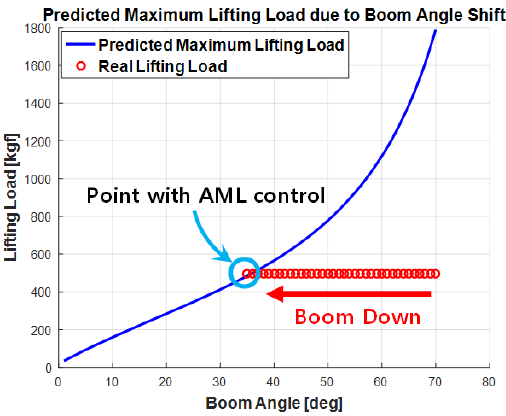
Figure 12. Simulation outputs given the predicted maximum weight and heavy object movement.